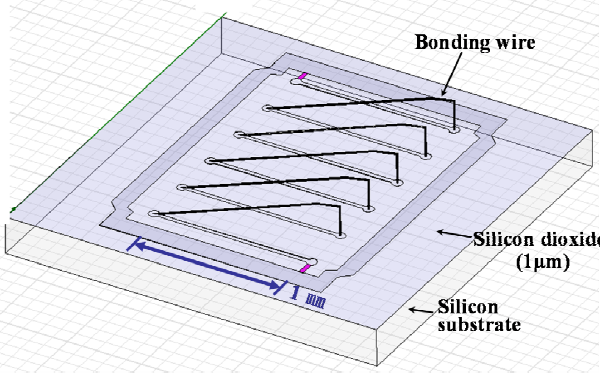
Figure 11. The simulation model of bonding wire inductor for Ansoft HFSS.